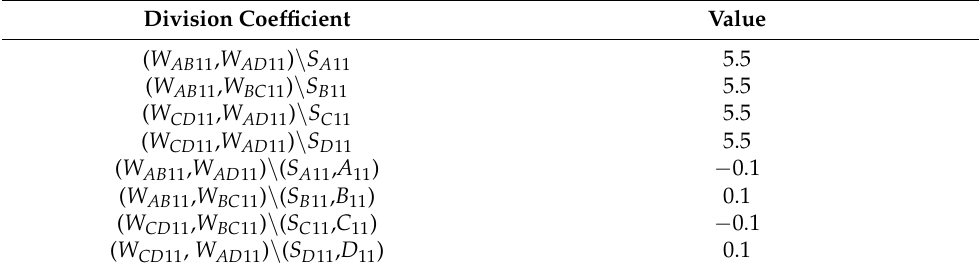
Table 2. The initial data defining the meshes Γ 11 and B v 11